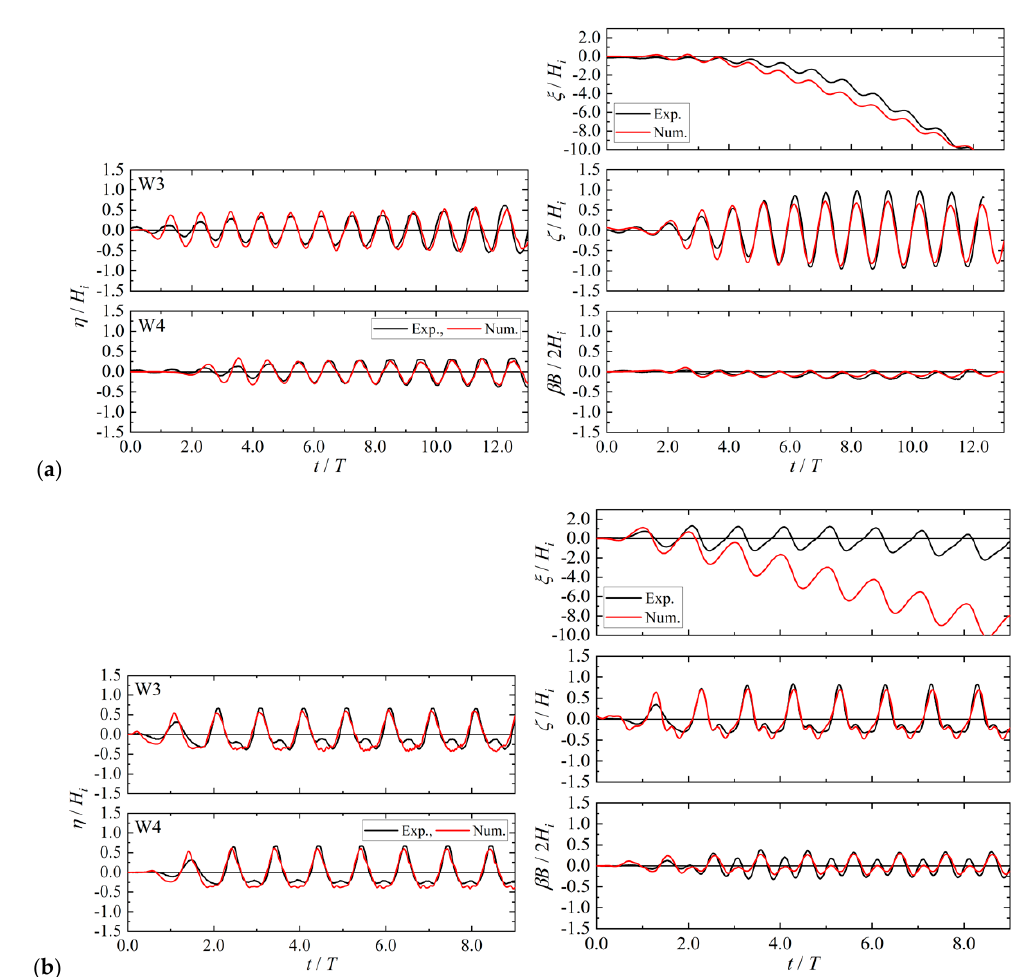
Figure 16. Comparison of the water surface fluctuations η and the surge ξ , heave ζ , and pitch β of the caisson for b f = 0 mm: ( a ) T i = 1.70 s ( f i = 0.59 Hz); ( b ) T i = 2.83 s ( f i = 0.35 Hz).